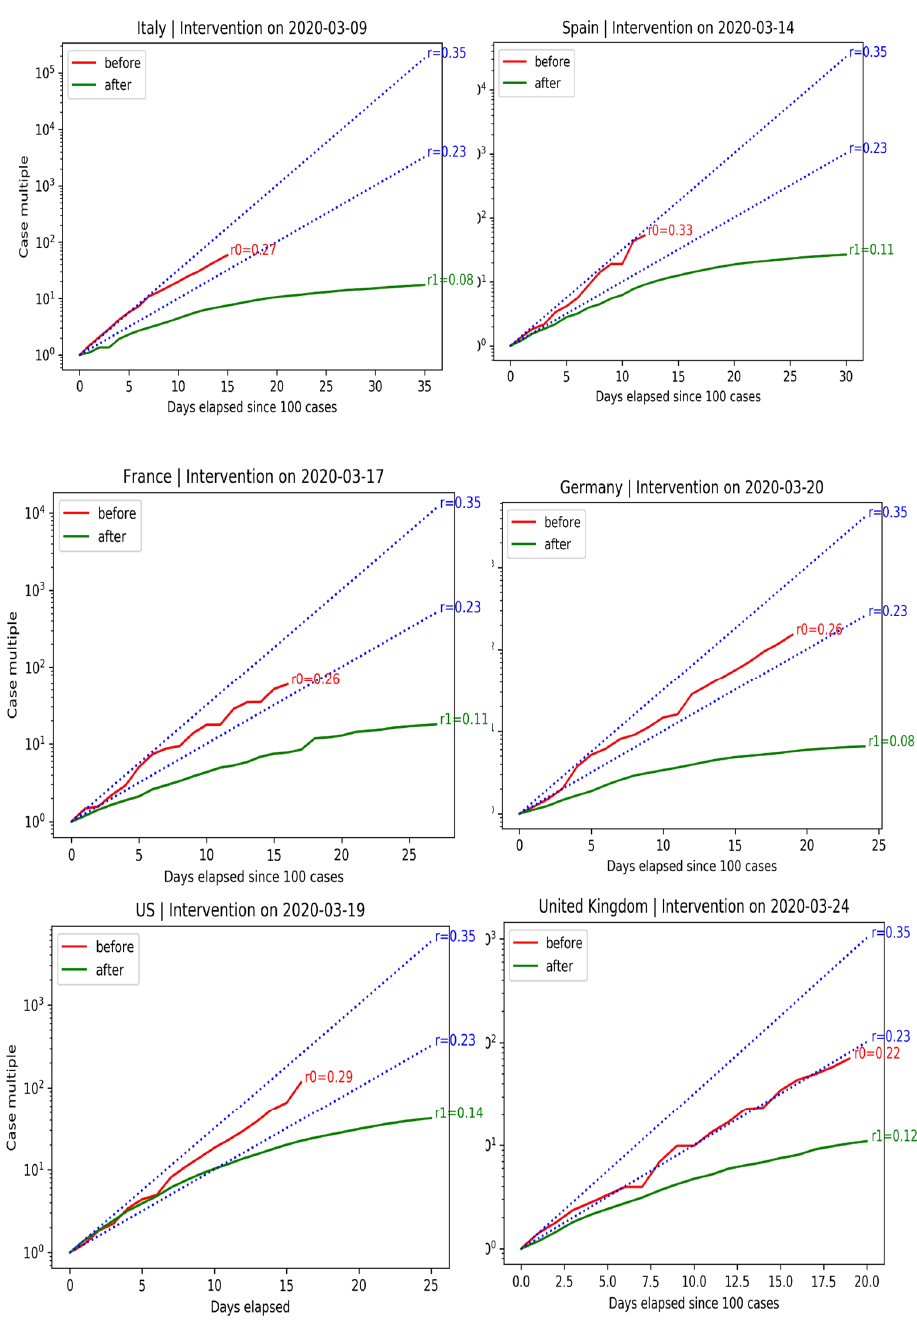
Figure 15. Spain and Italy have economies that rely heavily on tourism. The case of Spain was particularly alarming, with cases almost doubling every 2 days. Government-mandated lockdowns successfully curbed the spread of the disease. France and Germany also experienced exponential growth. Their governments were able to tame the spread of the disease without resorting to drastic lockdowns, like Spain and Italy. Before the government intervened, cases grew in the U.S. exponen- tially, at a growth rate of 0.29. Even after intervention, it took 10 days for cases to fall below the double-every-3-days line. Benefits are not instantaneous. U.K.’s COVID-19 growth rate of r 0 = 0.12 is in line with other European